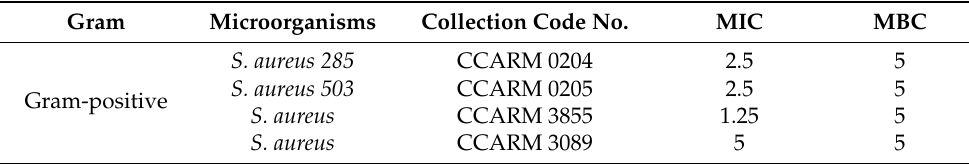
Table 5. MIC and MBC of THA-663S to multi-drug-resistant bacteria. Gram Microorganisms Collection Code